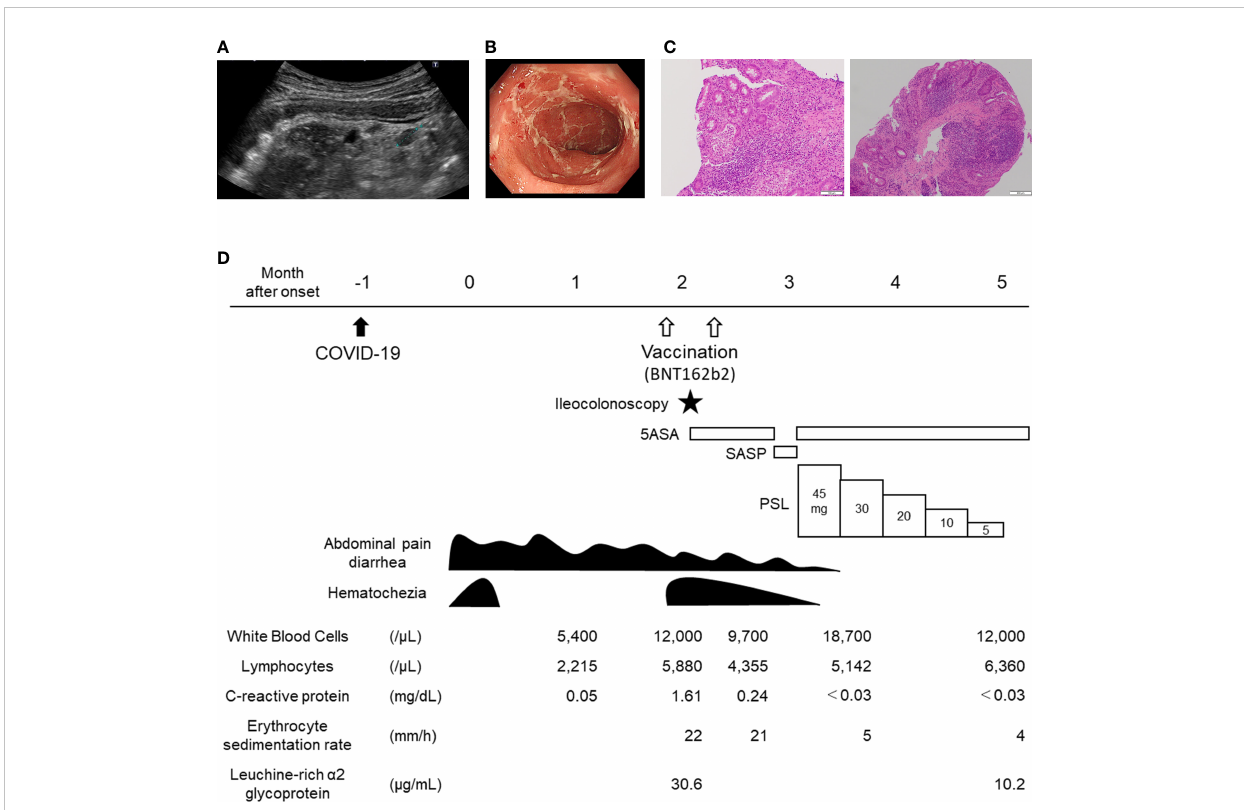
FIGURE 1 Clinical course of the 13-year-old patient with de novo ulcerative colitis post COVID-19. (A) Abdominal ultrasound depicting sigmoid colon. Wall thickening and loss of Haustra with mesenteric lymphadenopathy (dotted line) are shown. (B) Endoscopic image depicting sigmoid colon. Complete obliteration of vascular pattern with erosions are shown. (C) histology of ascending colon (left) and rectum (right): A crypt abscess in the ascending colon and crypt distortion in the rectum are shown. (D) Clinical course of the patient. COVID-19, coronavirus disease 2019; 5ASA, 5-aminosalicylate; PSL, Prednisolone; SASP,